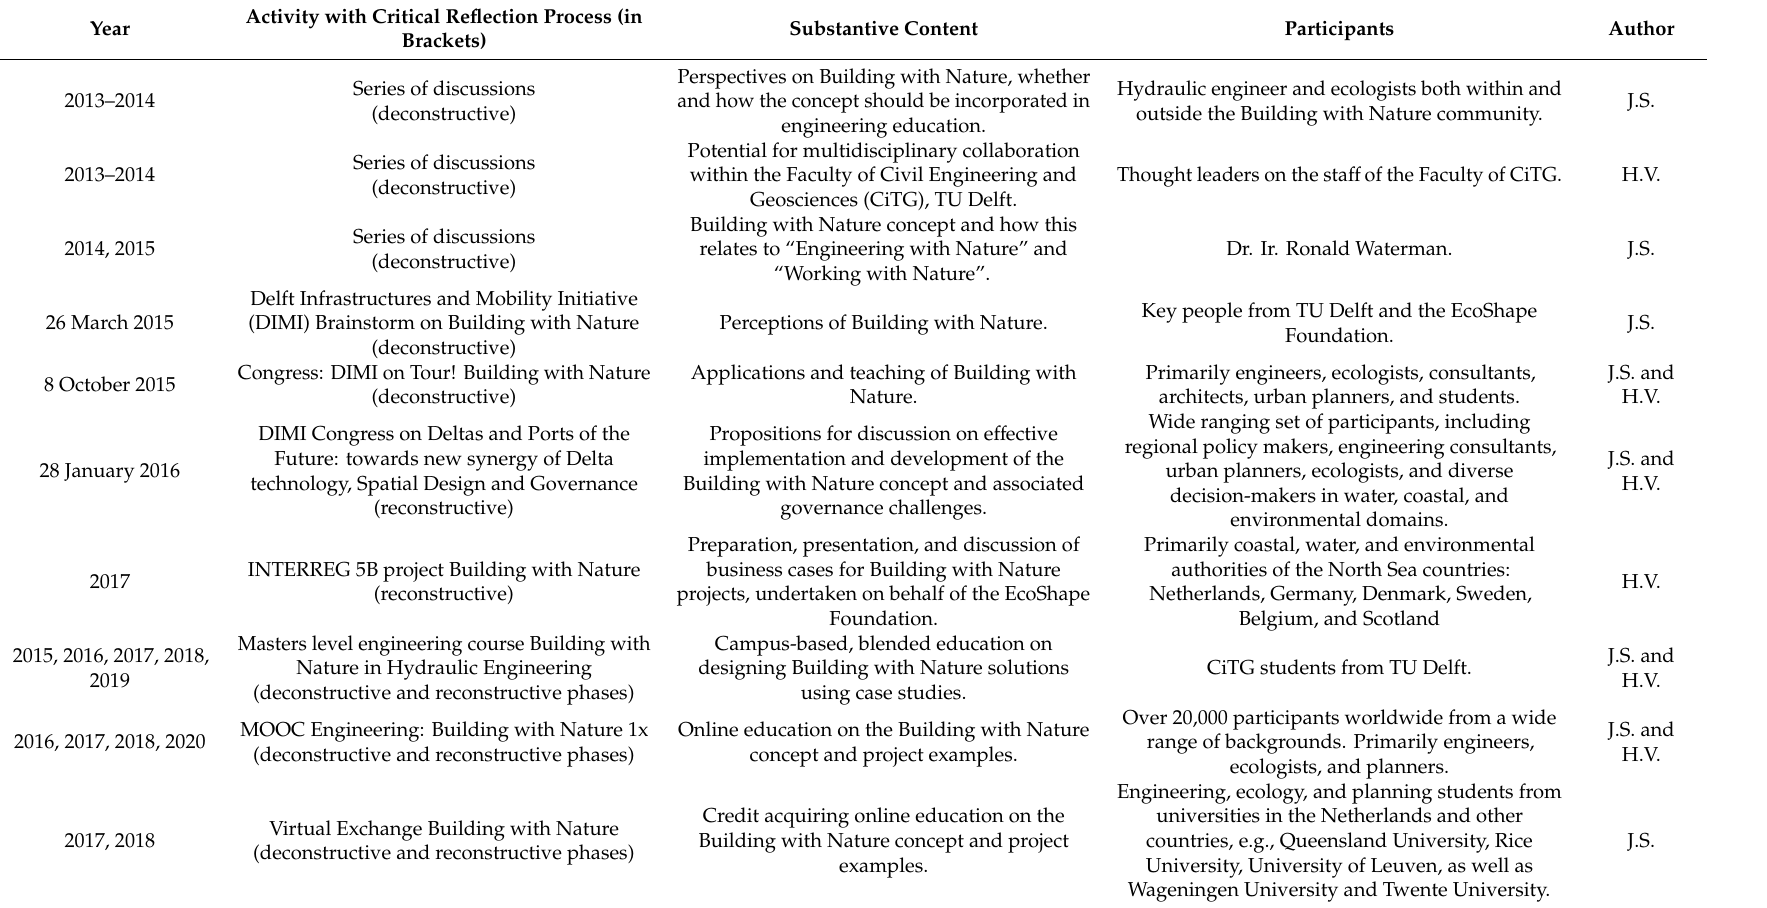
Table A1. Authors’ critical reflective experiences with coastal and river engineering over the period 2013 to